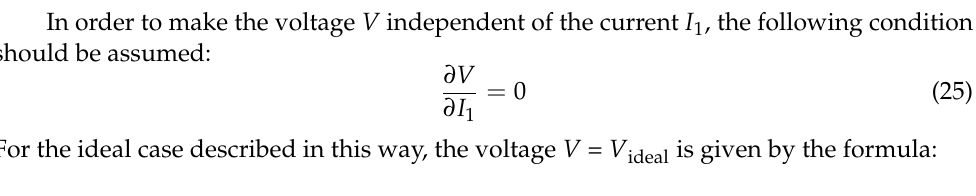
e - V conversion circuit.